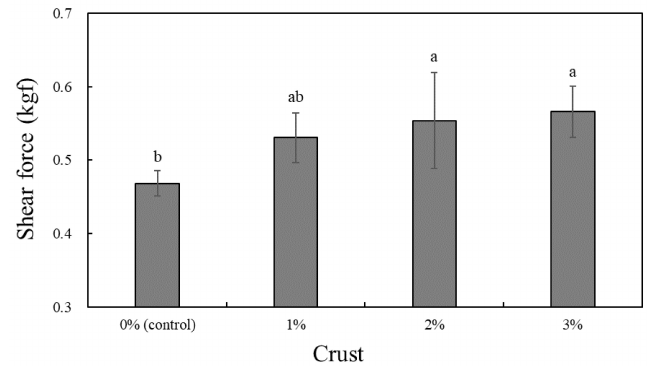
Figure 4. Shear force of pork patties formulated with various levels of crust derived from dry-aged beef (Hanwoo). a,b Represent statistically significant differences comparing the same color bar graphs ( p < 0.05).